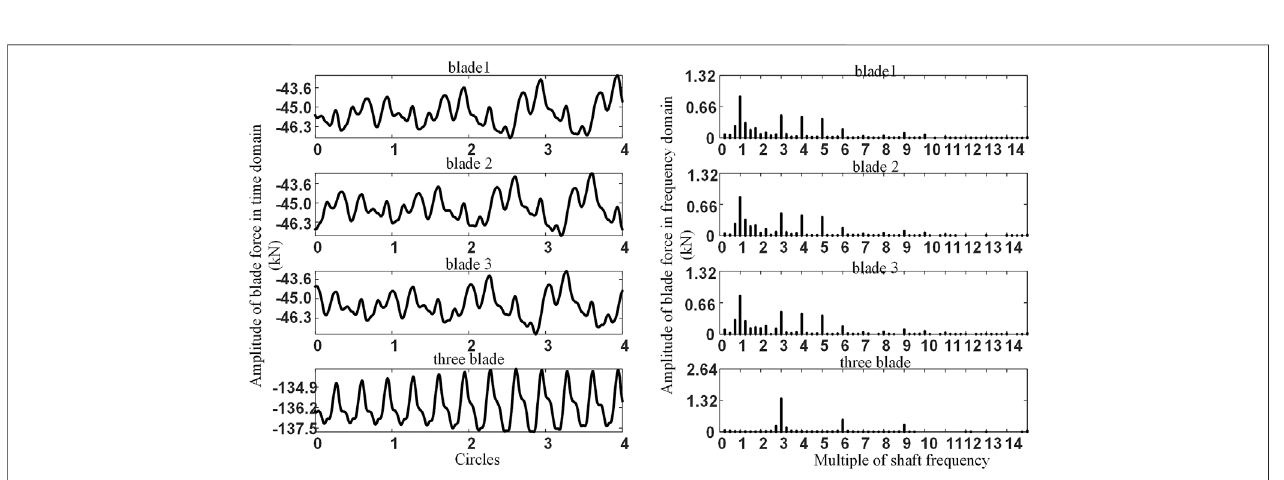
FIGURE 9 | Time and frequency domain diagram of the force on three